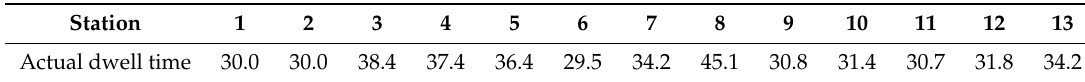
Table 4. Actual dwell time of a train at each station. Unit: s.